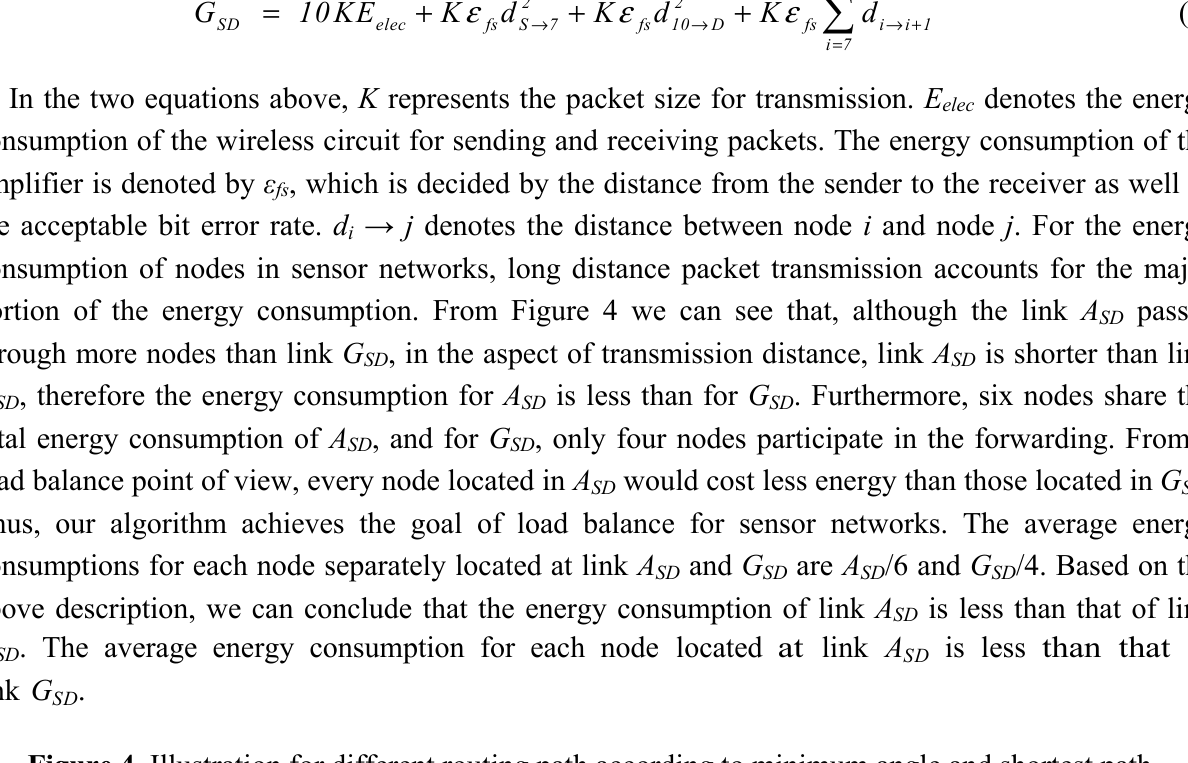
Figure 4. Illustration for different routing path according to minimum angle and shortest